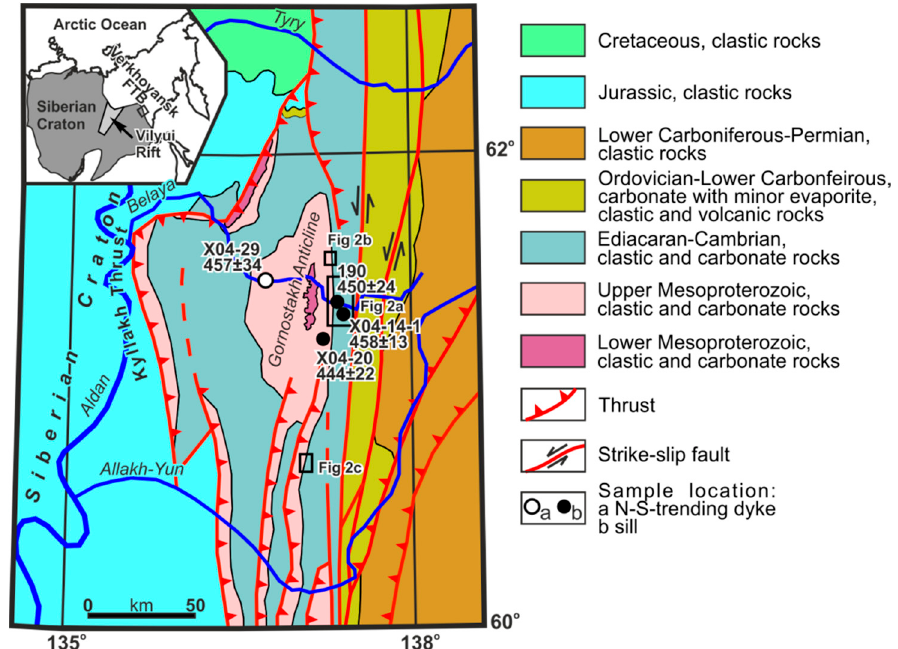
Figure 1. Simplified geological and sample location map of the central part of Sette-Daban Range and surrounding areas (geology after [22,26], simplified and modified). Data source for locations and age of intrusions: #190, 450 ± 24 Ma [8], #X04-29, 457 ± 34 Ma [9], #X04-20, 444 ± 22 Ma [10], X04-14-1, 458 ± 13 Ma, this study.